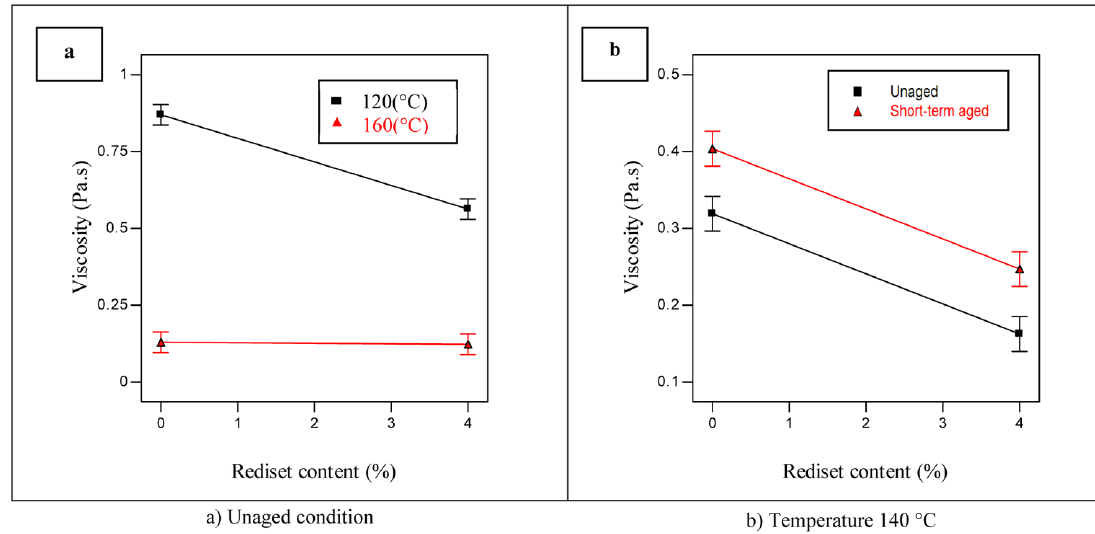
Fig. 4. Interaction effects of Rediset with temperature and aging condition on the value of viscosity for PG64